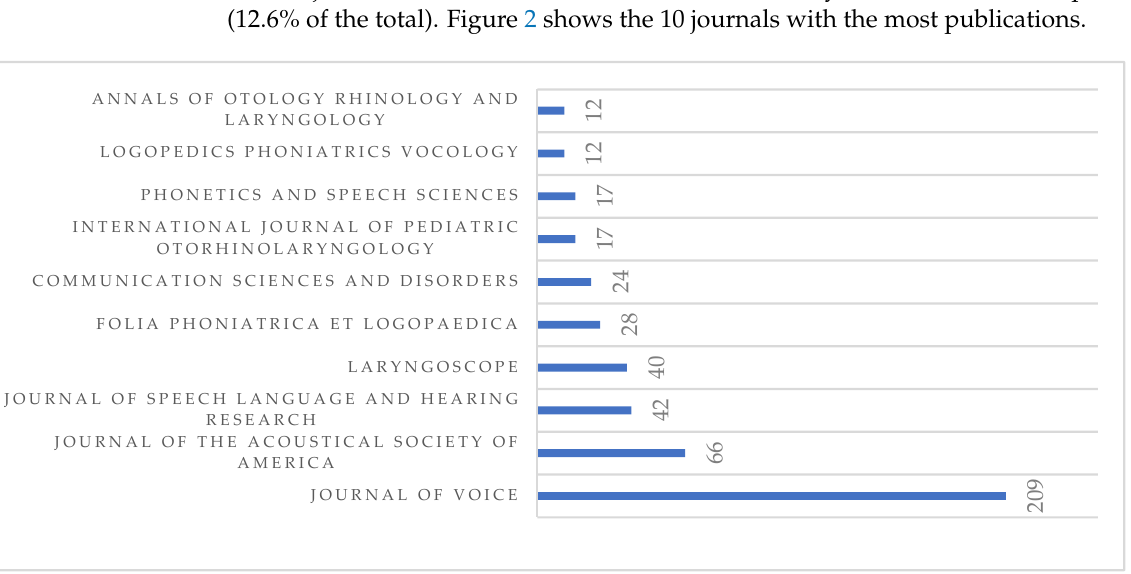
Figure 2. Number of publications per journal (from lowest to highest